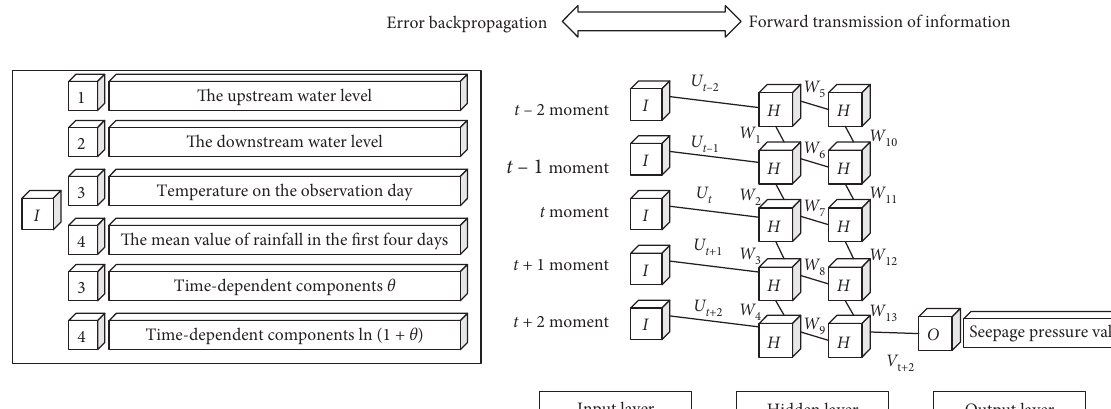
Figure 6: Network topology of the RS-LSTM prediction